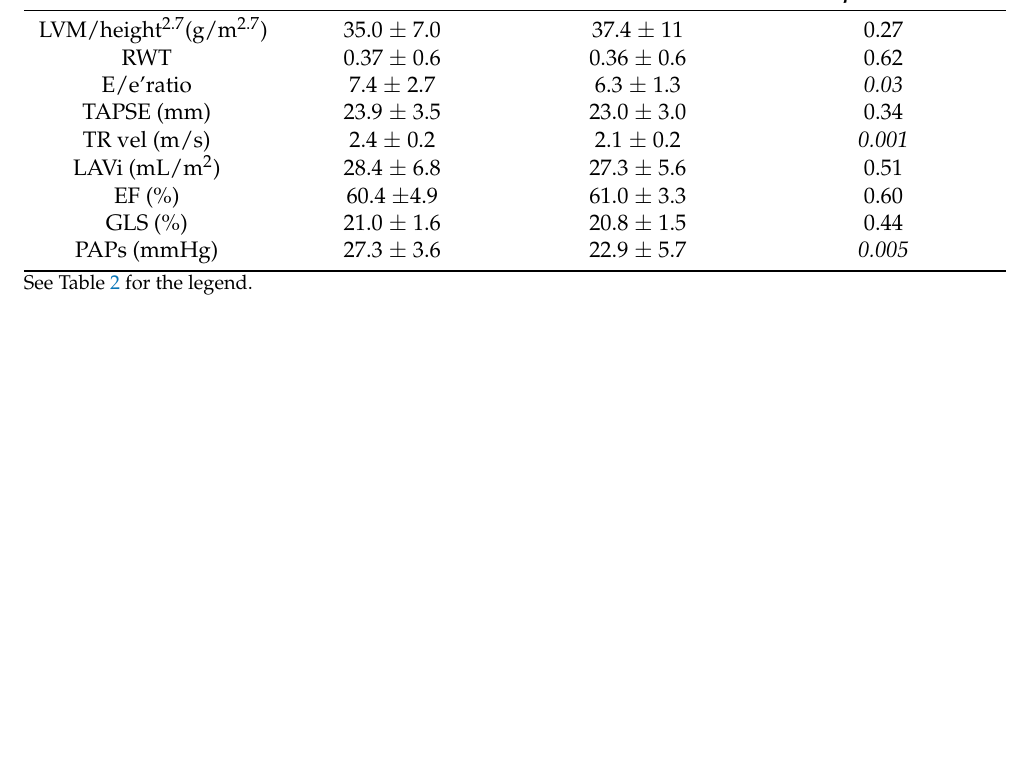
Table 3. Echocardiographic findings at 6 months of treatment with tadalafil.